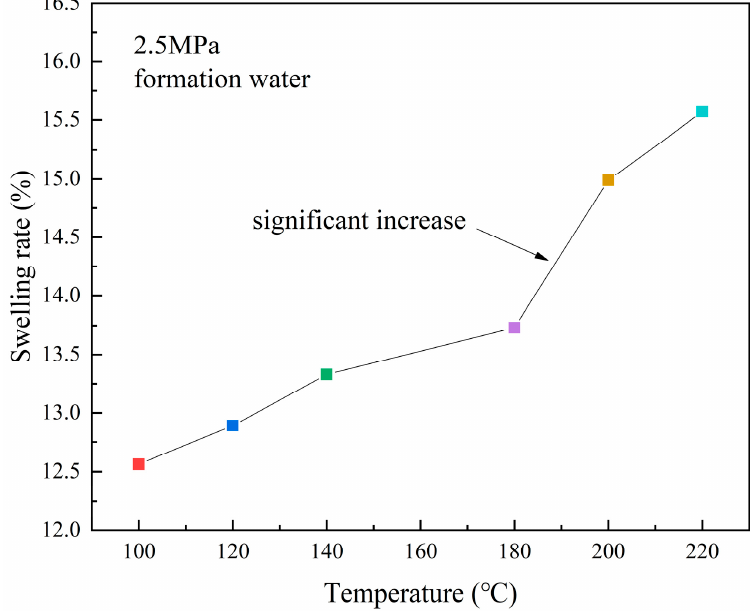
Figure 4. Swelling rate of artificial clay samples with temperature (2#a).